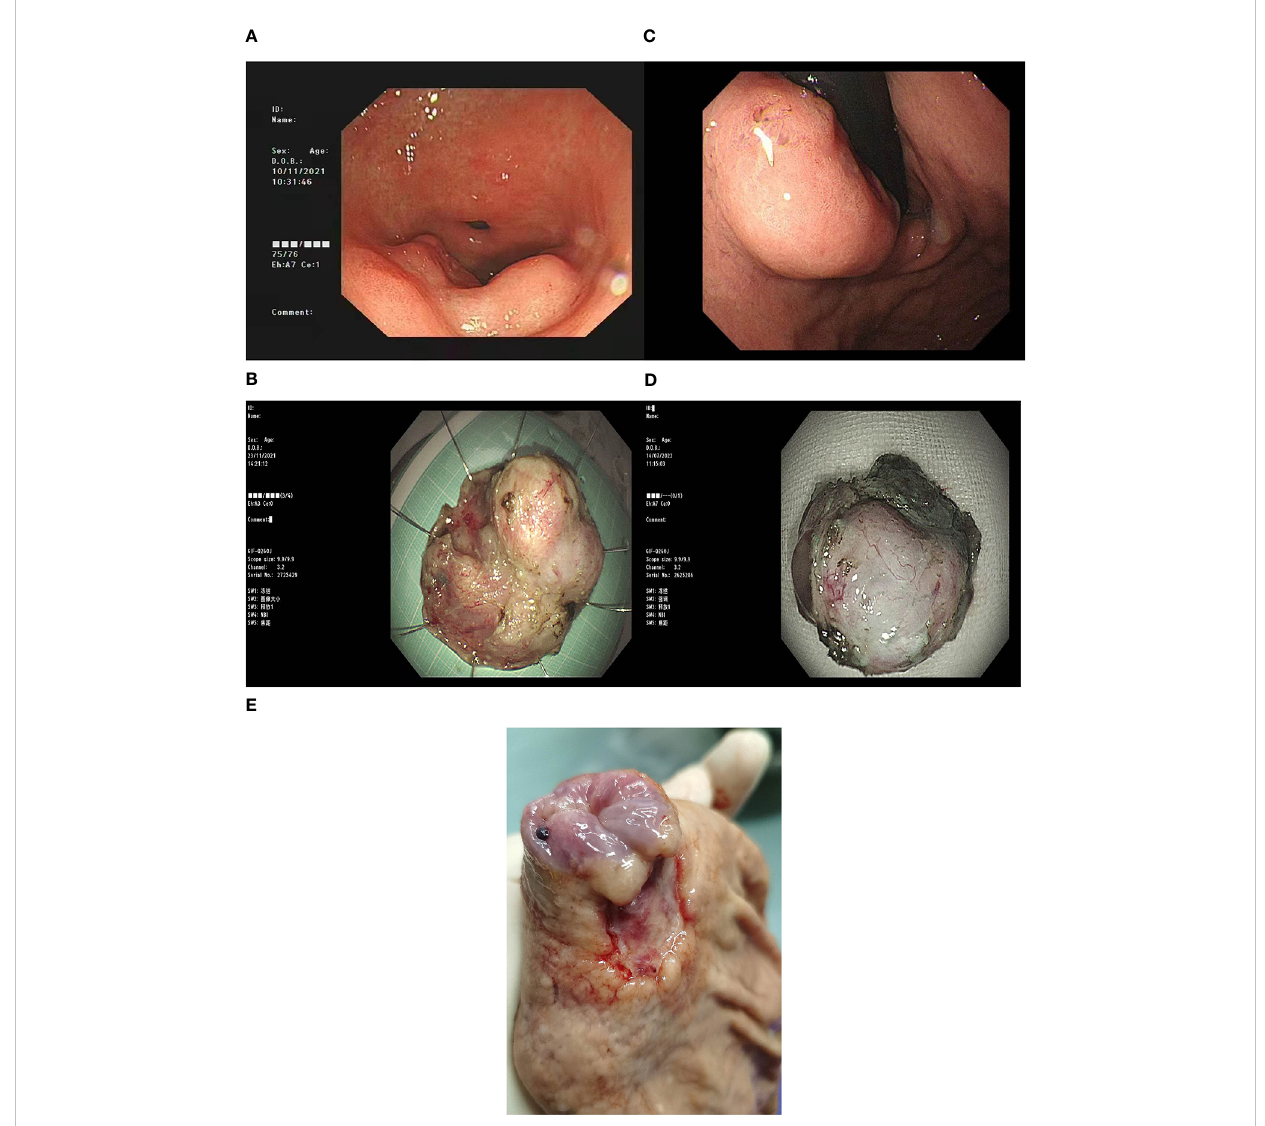
FIGURE 1 (A) ESDGastroscopy of case 1 showed a circumferential uplift lesion on the greater curvature of the antrum, with central depression, the maximum diameter of 5.0cm, and uneven surrounding mucosa. (B) ESD surgical resection specimen of Case 1. (C) Gastroscopy of Case 3 showed a submucosal bulge below the gastric cardia, with a maximum diameter of 2.0cm, and a shallow ulcer on the surface. (D) ESD resection specimen of Case 3. (E) In case 3, a gastric cancer radical specimen after ESD showed a mucosal defect in the cardia (caused